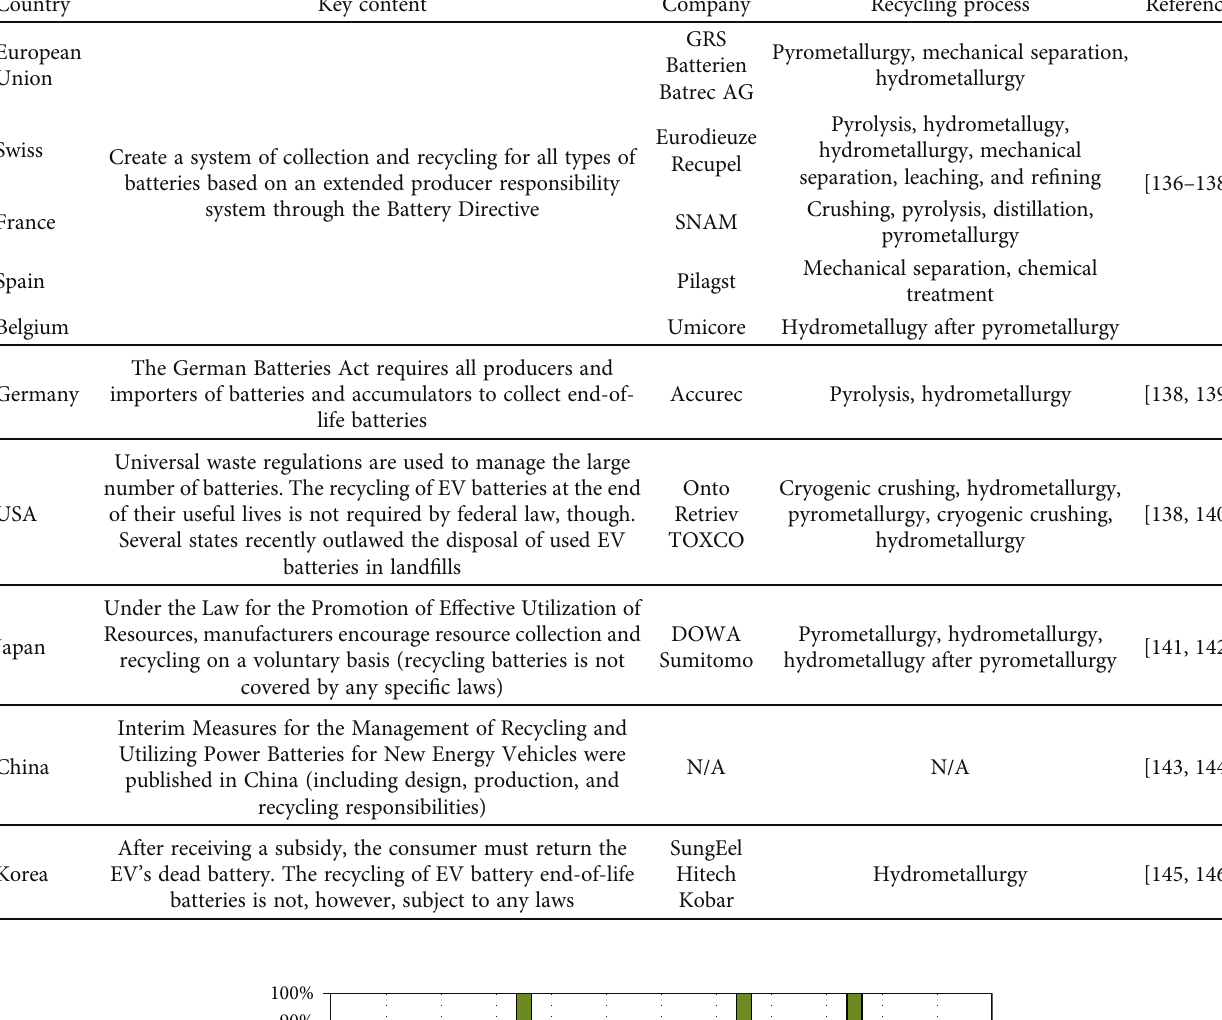
Table 2: Policy on recycling and recycling technology for metal recovery from end-of-life batteries of EVs. Country Key content